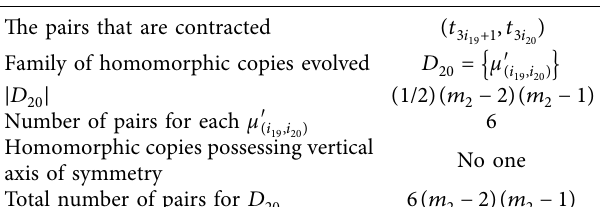
Table 19: Necessary information regarding homomorphic